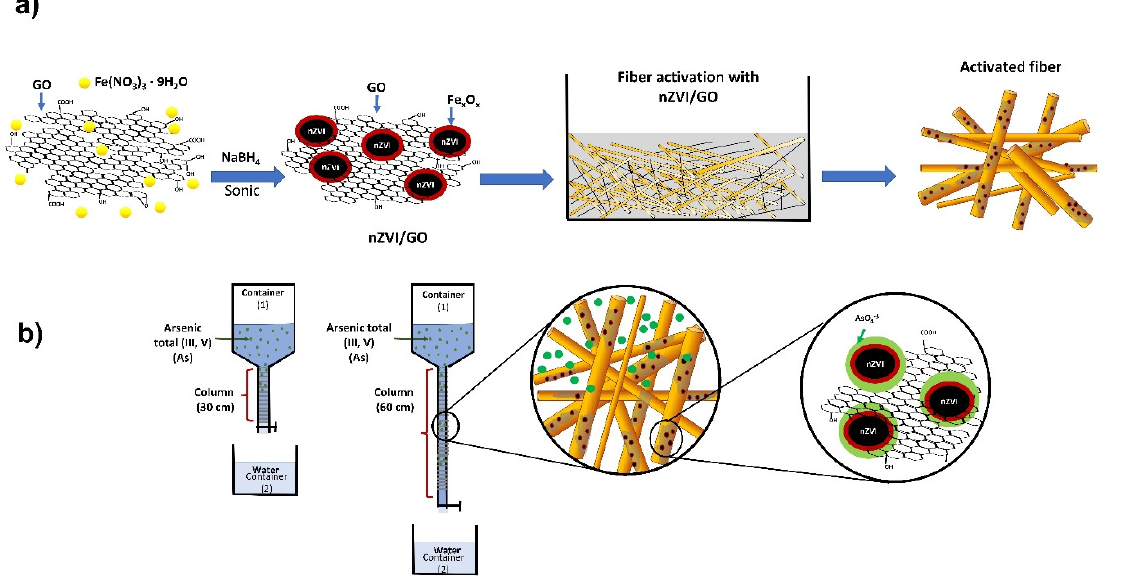
Figure 1. Schematic diagram of ( a ) synthesis of nZVI/GO and activation of jute fibers, ( b ) filtration columns.